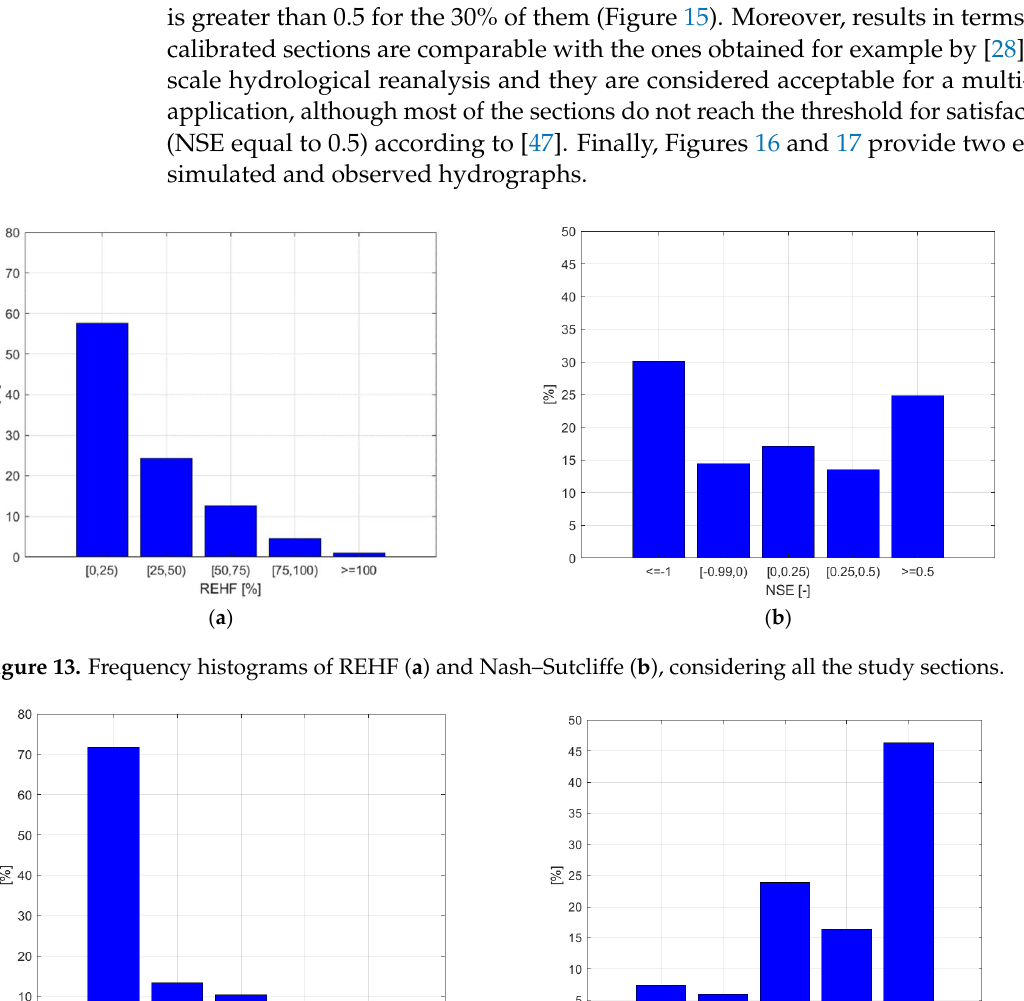
Figure 16. Comparison between observed and modelled hydrographs for a calibrated section.